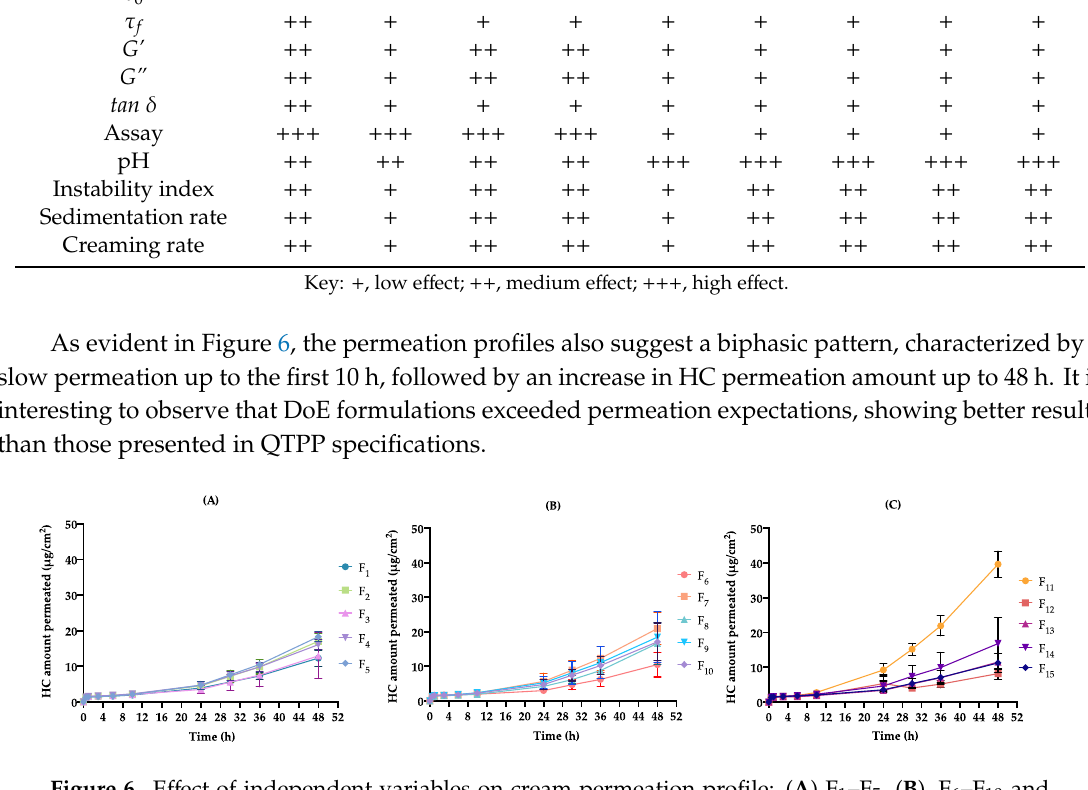
Figure 6. E ff ect of independent variables on cream permeation profile: ( A ) F 1 –F 5 , ( B ), F 6 –F 10 and Figure 6. Effect of independent variables on cream permeation profile: (A) F 1 –F 5 , (B), F 6 –F 10 and (C) ( C ) F 11 –F 15 F 11 –F 15 .